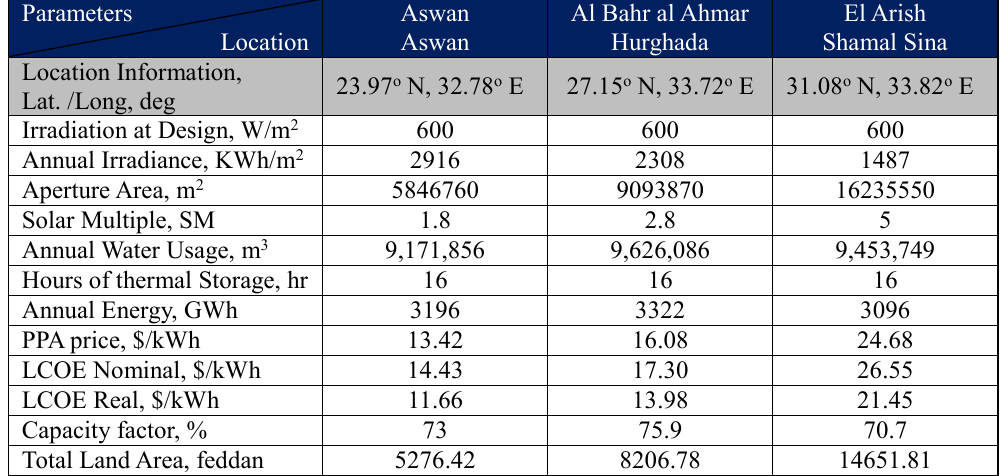
Cost analysis for wet cooling.